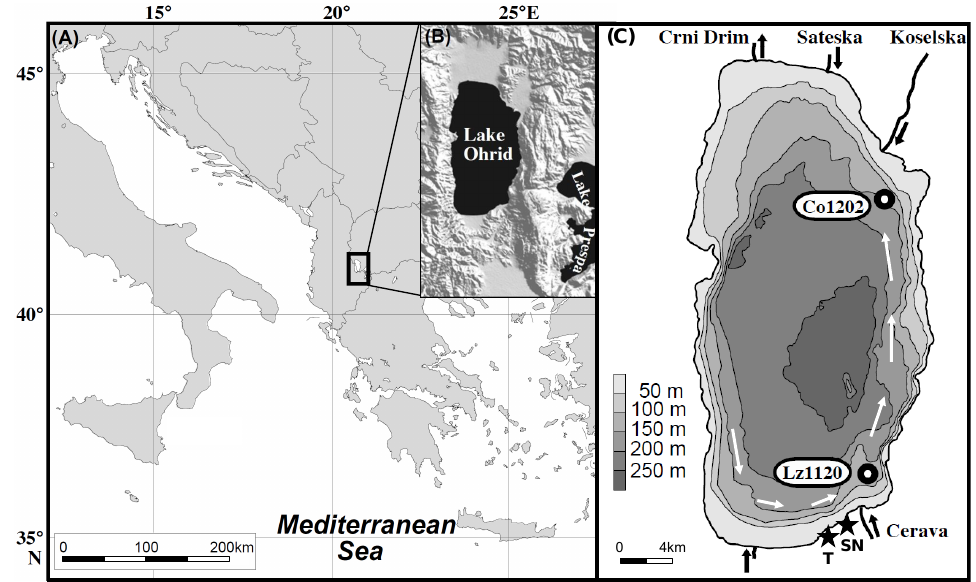
Fig. 1. Maps of SE’ Europe (A) and the Lake Ohrid Basin showing the topography and neighbouring Lake Prespa (B) , the bathymetry of Lake Ohrid and the positions of sites Lz1120 and Co1202 (C) . White arrows indicate the wind-induced surface currents in the catchments of the sites (according to Vogel et al., 2010c). Asterisks mark the karst springs at Tushemisht (T) and Sveti Naum (SN). Note that Lz1120 is influenced by run-off from the low lands at the southern shores, the karst springs and the Cerava River while the catchment of Co1202 includes surface run-off from the steep eastern slopes,